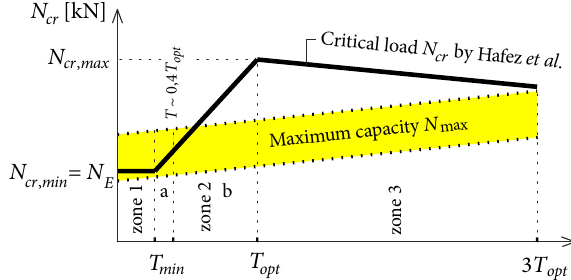
Fig. 3. Maximum load-carrying capacities N columns with respect to critical buckling loads N the initial prestress T according Wadee et al.